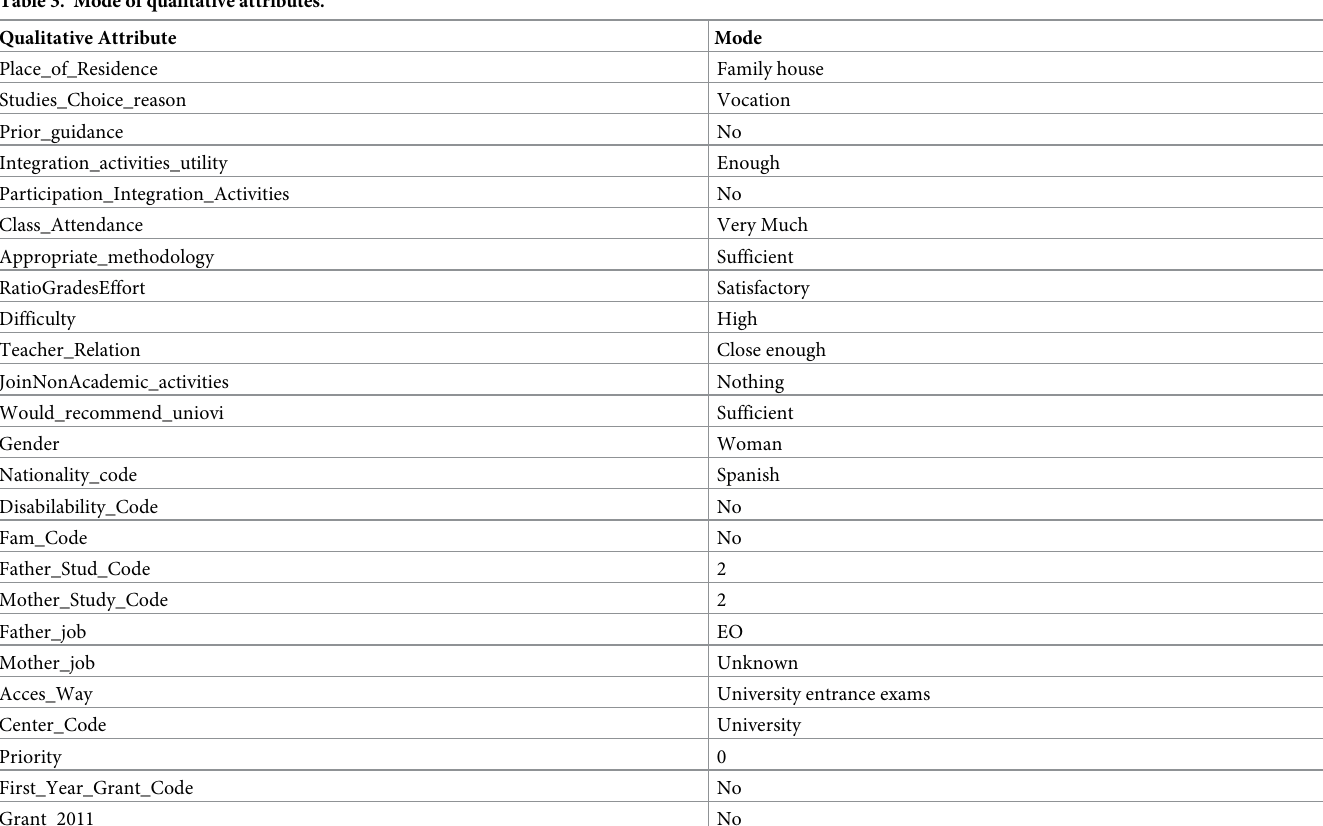
Table 3. Mode of qualitative